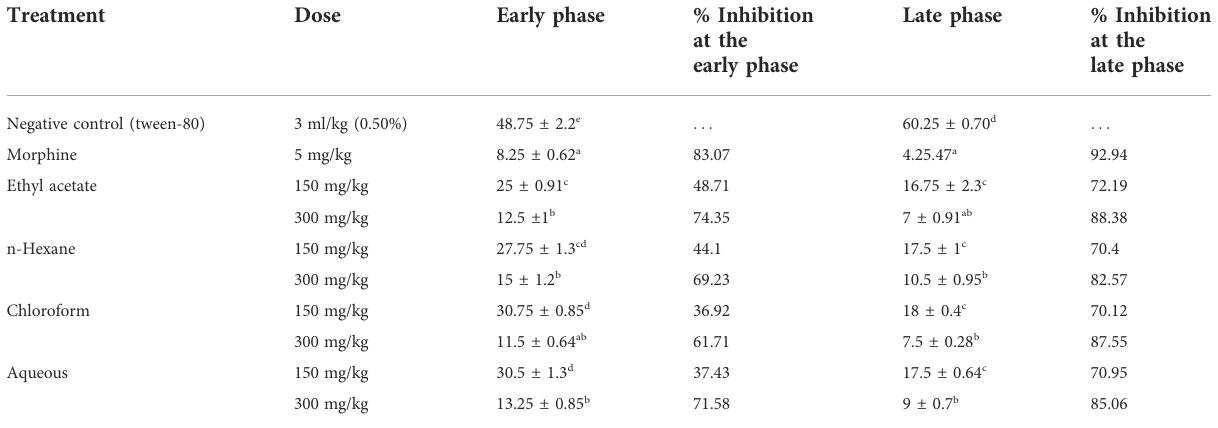
TABLE 1 Effect of Justicia adhatoda in different fractions on formalin-induced pain in mice. Treatment